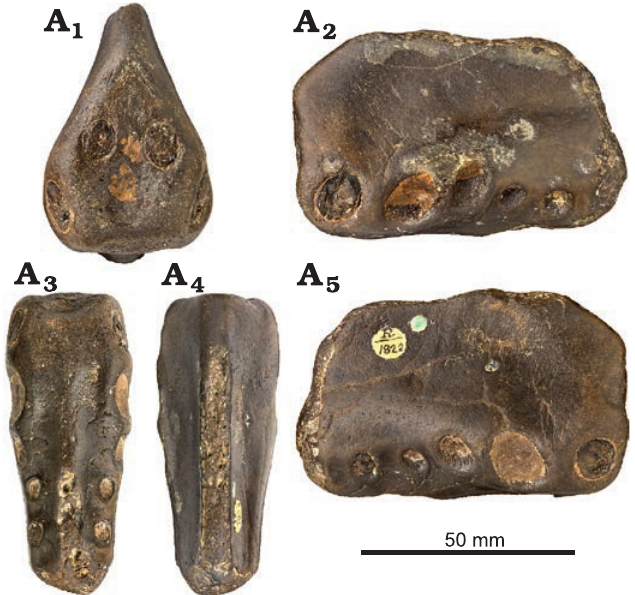
Fig. 1. Anhanguerid pterosaur Coloborhynchus clavirostris Owen, 1874, NHMUK PV R1822, St. Leonards­on­Sea, East Sussex, England, late Berriasian–Valanginian. In anterior (A 1 ), left lateral (A 2 ), palatal (A 3 ), dorsal (A 4 ), and right lateral (A 5 ) views. Photographs from NHMUK data portal collections